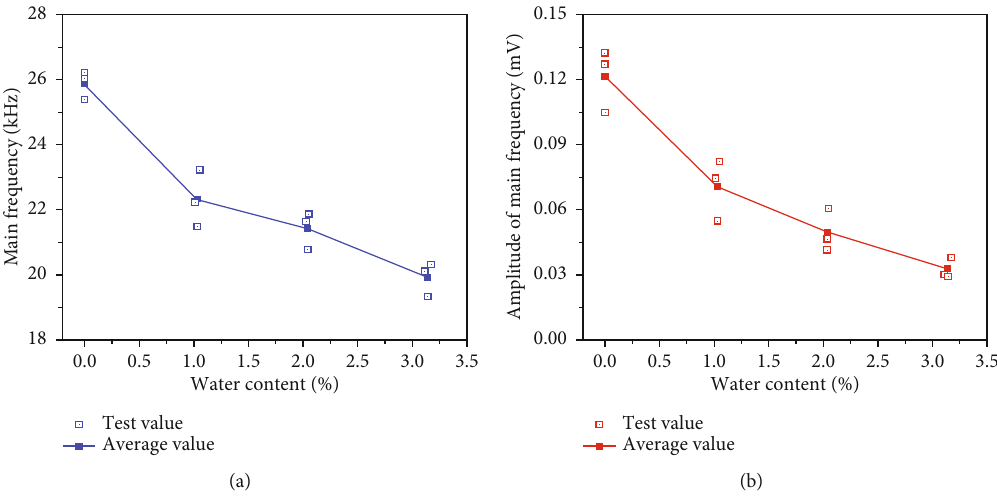
Figure 9: Main frequency and main-frequency amplitude of samples with di ff erent water